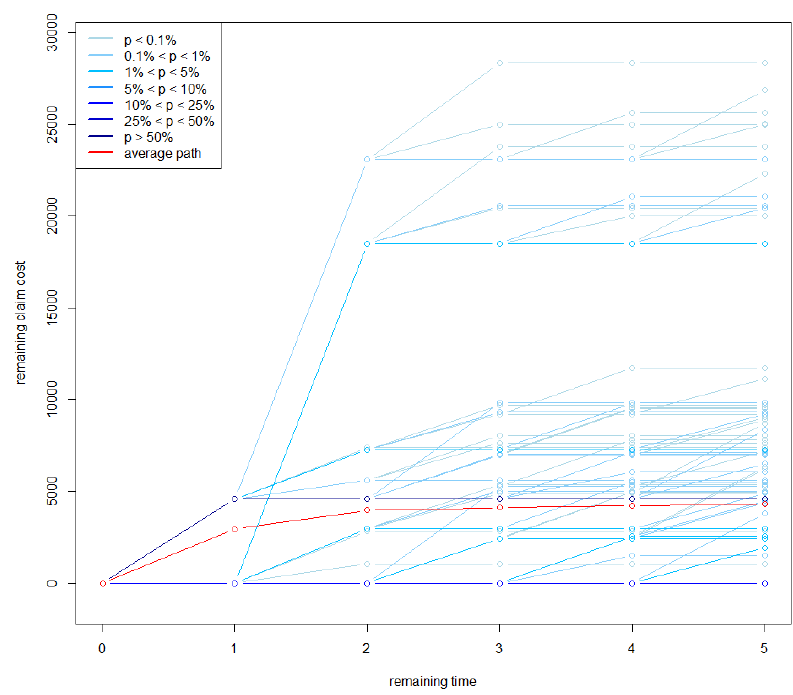
Figure 5. Representation of N = 5000 simulated paths for the type-2 cost development of the chosen ( ν ) claim C . The average path is in 6,0